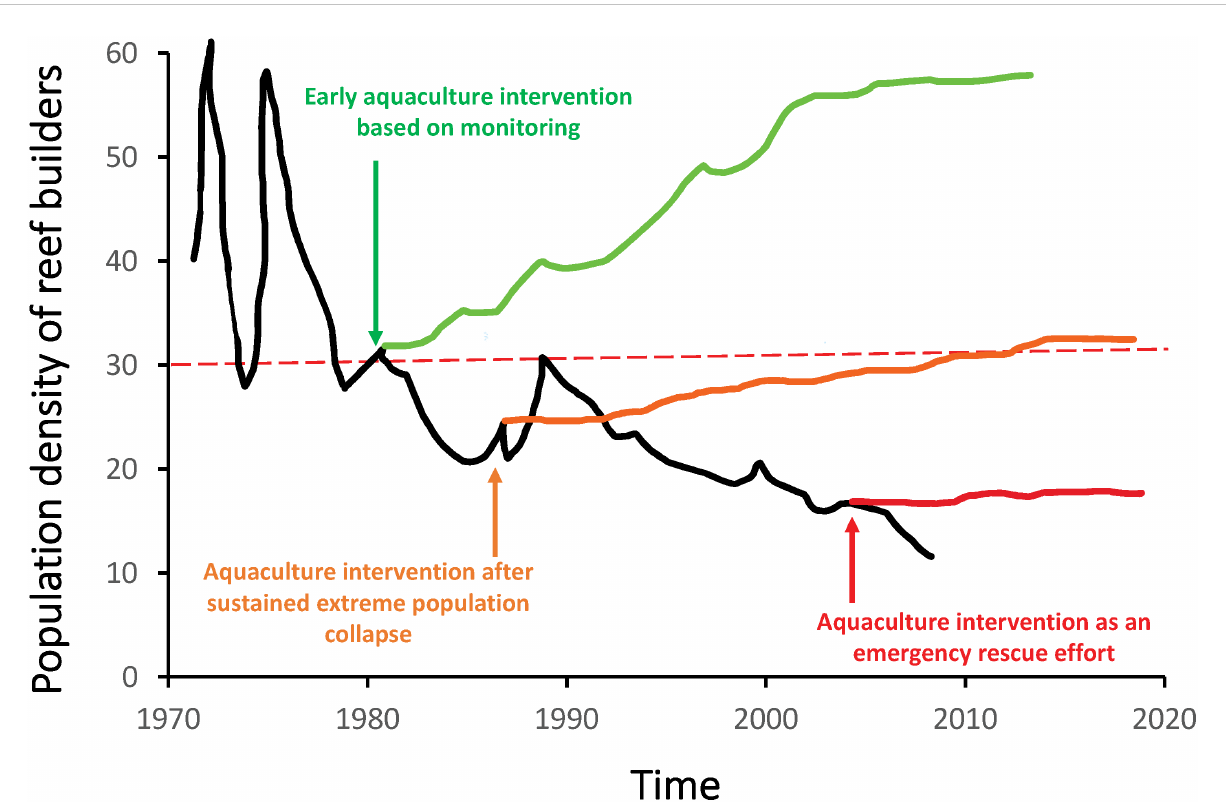
FIGURE 2 Early aquaculture interventions can increase ef fi cacy by stabilizing larger populations of reef builders and maintaining functions and services that they provide. Early aquaculture interventions (green arrow, at a threshold of <30% coral cover, red dotted line) maintain higher genetic diversity, and integrity in ecosystem structure, function and services, making recovery to former population densities and conditions more likely (green line). Later interventions (orange arrow) may prevent populations from further collapse and allow for more modest recovery (orange line) based on the remaining genetic resources and ecosystem status at the time of implementation. Late-stage emergency efforts may prevent species or population extinction (red arrow), but much genetic diversity, system functioning and services are likely to be lost from remnant populations (solid red line). Population density data (black line) is percent live coral cover in Caribbean coral reefs from 1973 to 2010 (Serge, 2013), but could be any measure of population density (e.g. oysters per m 2 ), reef integrity, or relevant ecosystem function or